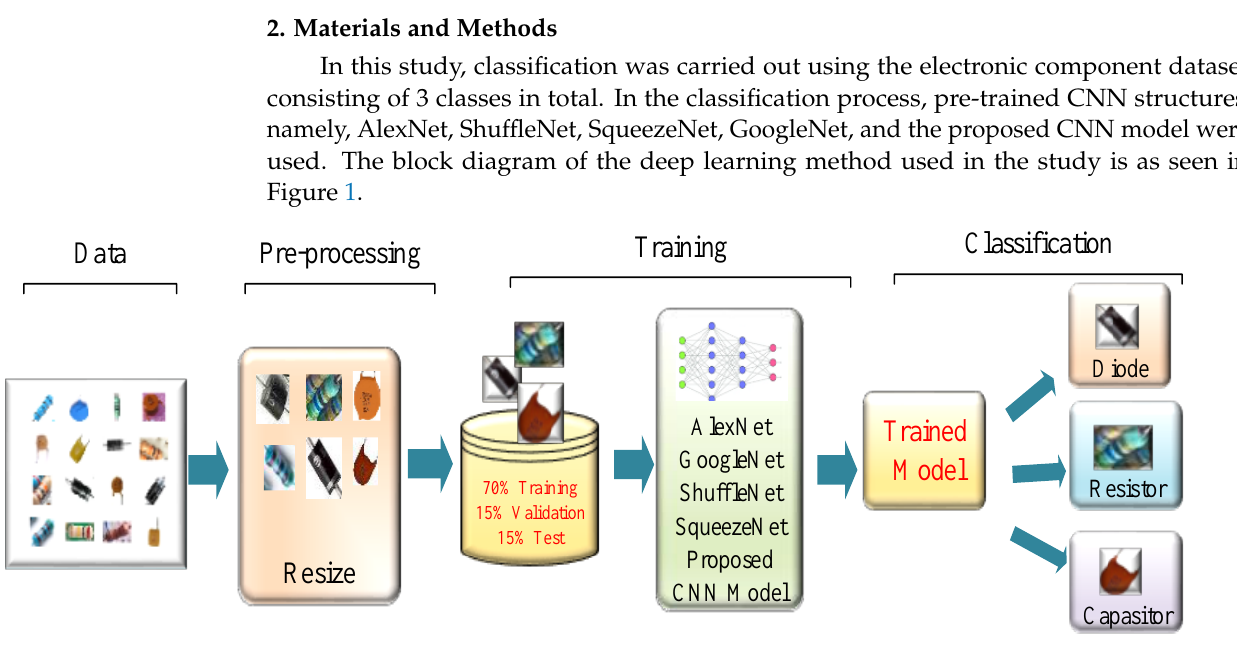
Figure 1. Block diagram of the proposed deep learning method.